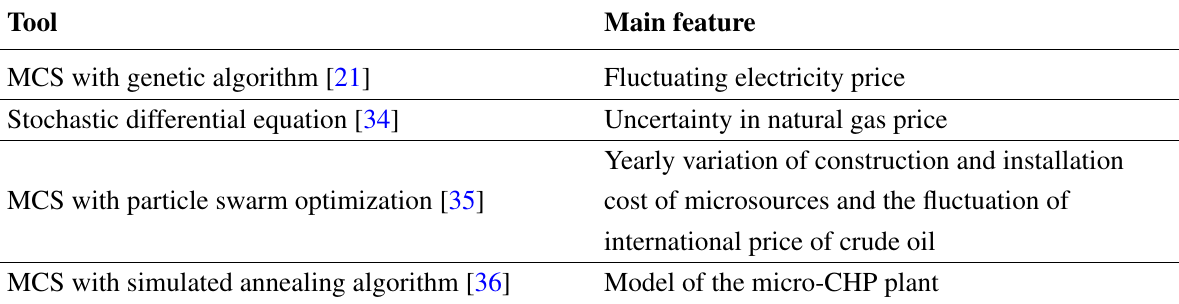
Table 2. Stochastic optimization tools for microgrid planning. CHP, combined heat and